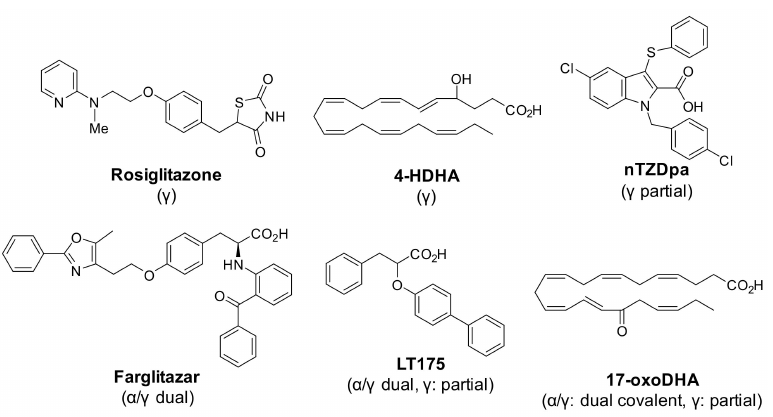
Figure 1. Structures of PPAR γ agonists rosiglitazone and 4-HDHA, partial agonist nTZDpa, PPAR α / γ dual agonist farglitazar, dual and partial agonist LT175, and dual covalent and par- tial agonist